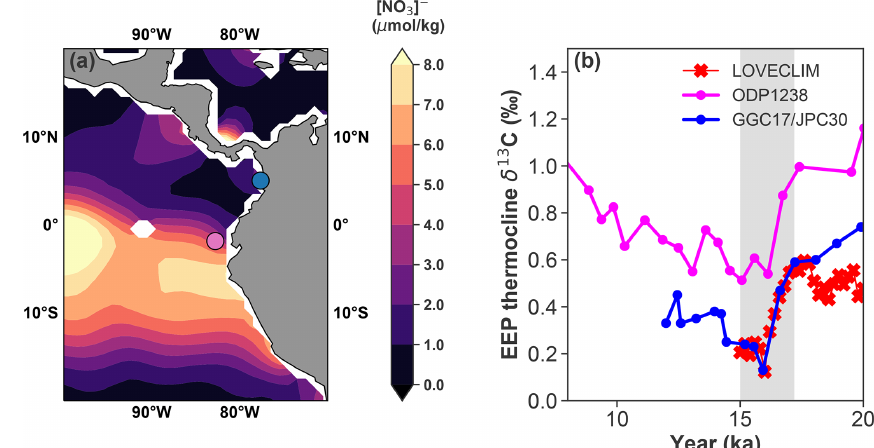
Figure 9. (a) Modern sea surface nitrate concentration from the WOA-18 dataset. The sites of ODP 1238 and GGC17/JPC30 are marked as a purple and blue circle, respectively. (b) Neogloboquadrina dutertrei ( N. dutertrei , a shallow thermocline species) δ 13 C data from ODP 1238 (Martínez-Botí et al., 2015) and GGC17/JPC30 (Zhao and Keigwin, 2018), as well as LOVECLIM-simulated δ 13 C of DIC at 100m (average of 82–90 ◦ W, 5 ◦ S–5 ◦ N). The N. dutertrei data are corrected by − 0 . 5‰ to normalize to δ 13 C of DIC (Spero et al., 2003). The grey shaded bars highlight the time period we focus on in this study.